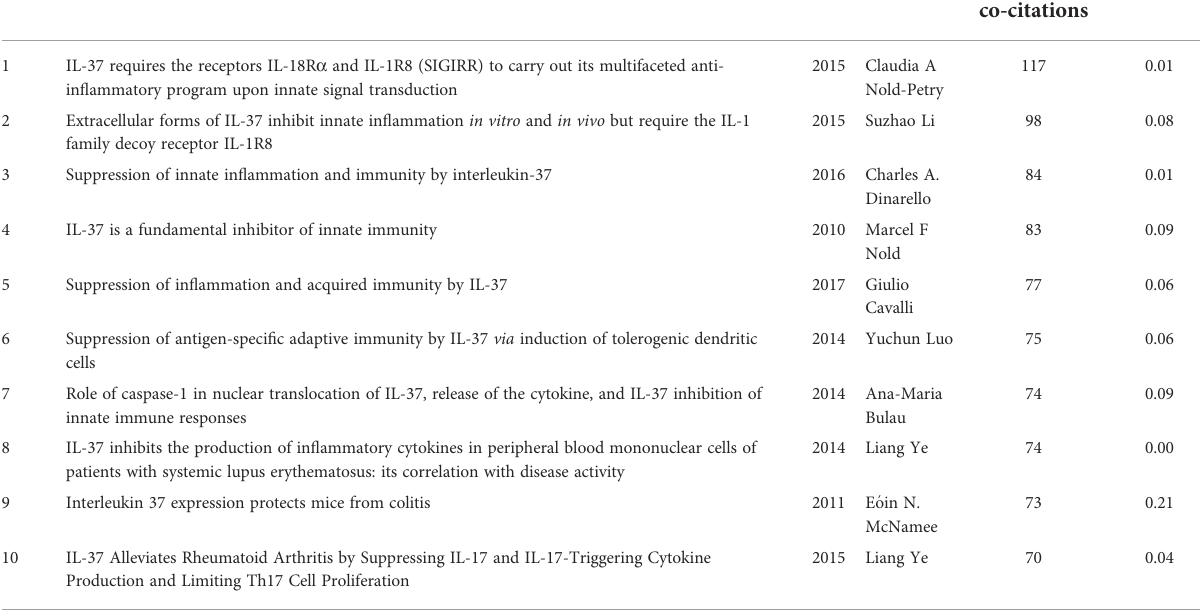
TABLE 4 The top 10 co-cited references of IL-37